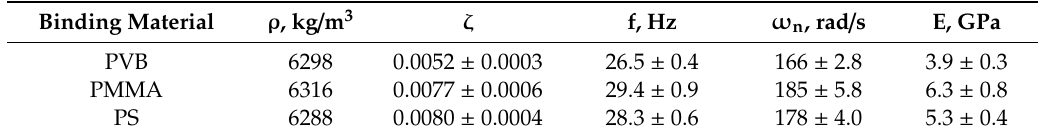
Figure 7. Experimental setup for determination of mechanical and electrical characteristics of the samples: 1, sample holder; 2, LK-G82 sensor head; 3, LK-G3001PV control block; 4, PicoScope oscilloscope; 5, computer.